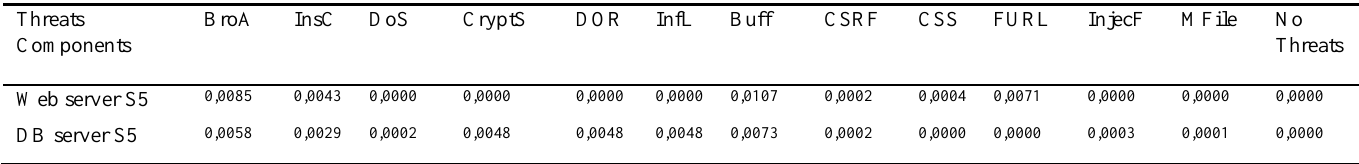
Table 10 The Impact Matrix S5 (IM S5)